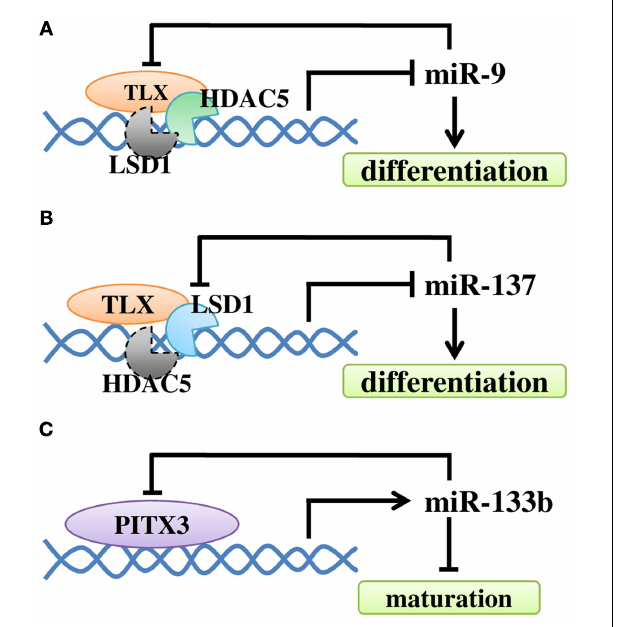
FIGURE 4 |The regulatory loop between miRNAs and their regulators in NSC differentiation and neuronal maturation. (A) Negative feedback regulatory loop of miR-9 andTLX.TLX recruits HDAC5 to the miR-9 locus to inhibit miR-9 expression. MiR-9 can repress the level ofTLX through its 3 (cid:2) UTR. At the same time, LSD1 may be recruited. (B) TLX recruits LSD1 to the miR-137 locus to inhibit miR-137 expression.The expression of miR-137 can repress the level of LSD1. Similarly, HDAC5 may be recruited. (C) Transcription factor Pitx3 promotes miR-133b expression, while miR-133b can down-regulate Pitx3